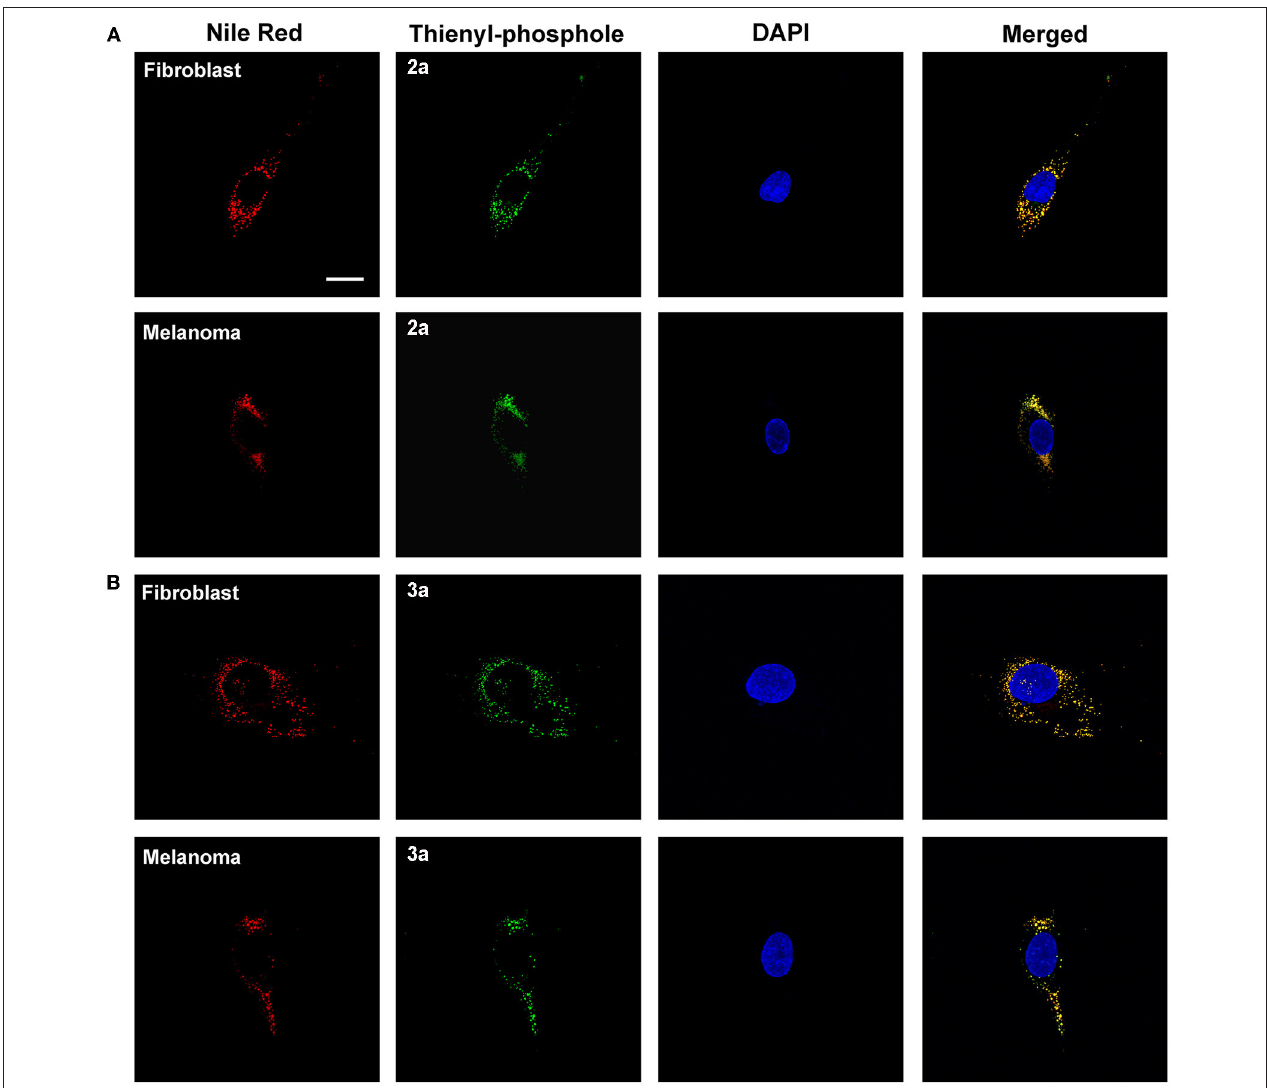
FIGURE 6 | Intracellular targets of the thienyl-phospholes. Fluorescence images of human fibroblasts (AG01518) and malignant melanoma cells (SK-MEL-28) stained with phospholes 2a (A) and 3a (B) (green, 10 µ M, 24 h). After fixation the cells were stained with 0.1 µ g/ml Nile Red (red) and the cell nuclei was visualized with DAPI staining (blue). The phospholes displayed a high congruence in staining pattern with Nile Red, as seen as yellow in merged images, indicating that the phospholes stain lipid droplets. Images were collected in z-stack mode (excitation at 405 and 535 nm) with the dimensions x = 135 µ m, y = 135 µ m, and z